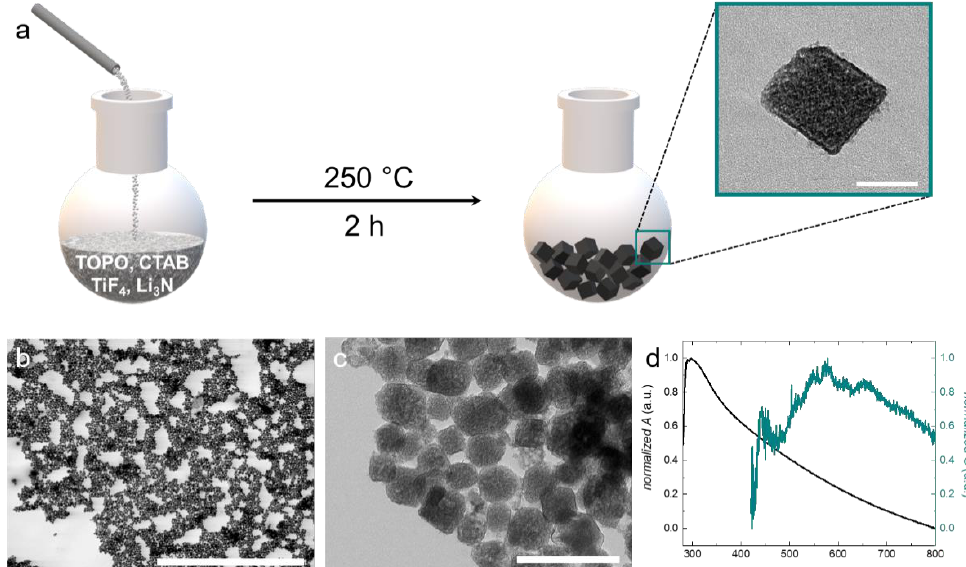
Figure 1. ( a ) Schematic illustration of the reaction procedure. TiF 4 and Li 3 N are dissolved in trioctylphosphine oxide (TOPO) and cetrimonium bromide (CTAB) and reacted at 250 °C for 2 h to form cubic or cube-like titanium oxynitride (TiON) nanoparticles. ( b ) STEM image of the narrowly dispersed TiON nanoparticles. ( c ) TEM image of the synthesized TiON nanoparticles. ( d ) Optical properties of the TiON nanoparticles. The black curve displays the absorbance of the TiON nanoparticles; the cyan curve displays the contribution of scattering to the absorbance. The scale bars represent: ( a ) = 50 nm, ( b ) = 5 μm, ( c ) = 200 nm.